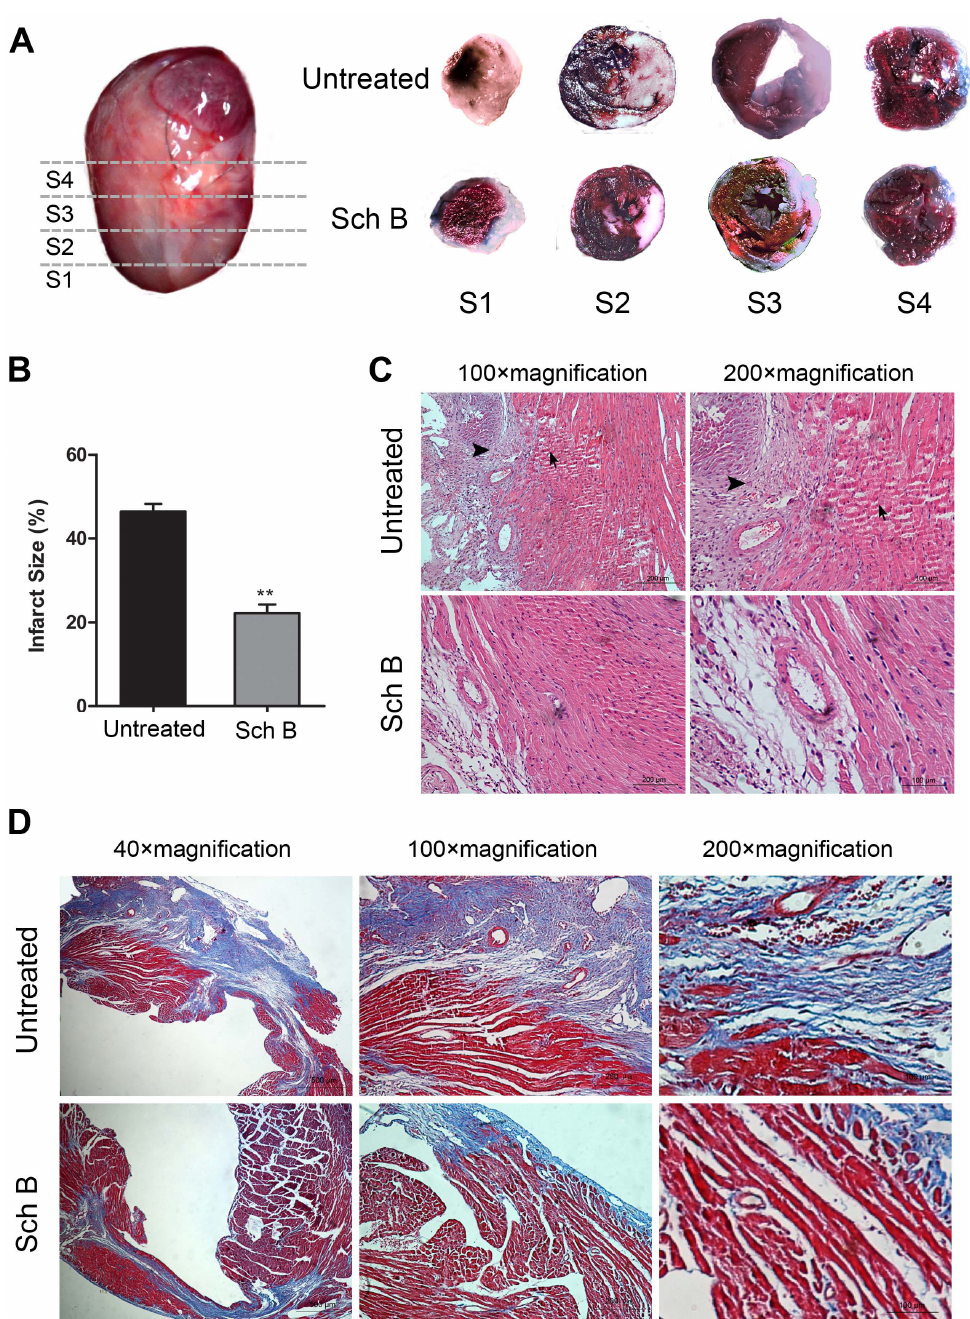
Figure 3. Pathological changes of the morphology in Sch B treated group and the untreated group in MI mice. (A) Hearts were cut transversely into 4 slices at 3 weeks after MI. Each slice was stained with Evans blue and triphenyltetrazolium chloride (TTC). Viable myocardium stains red, while the infarct area stains pale. (B) Infarct size analysis of Sch B treated group and the untreated group. Infarct size expressed as percentage infarction of the area at risk in hearts. Area at risk as percentage of the area of whole left ventricle didn’t differ between the two groups. (C) Representative illustration of hematoxylin and eosin staining of infarcted mouse hearts. These photos demonstrated the intense inflammatory response ( arrowheads ) and myocardial cells arranged irregularly ( arrows ) after MI. (D) Representative images of Masson’s Trichrome-stained infarcted hearts in mice. Blue represents region with replacement fibrosis. n=6 per group, * P , 0.05 versus untreated group, ** P , 0.01 versus untreated group.